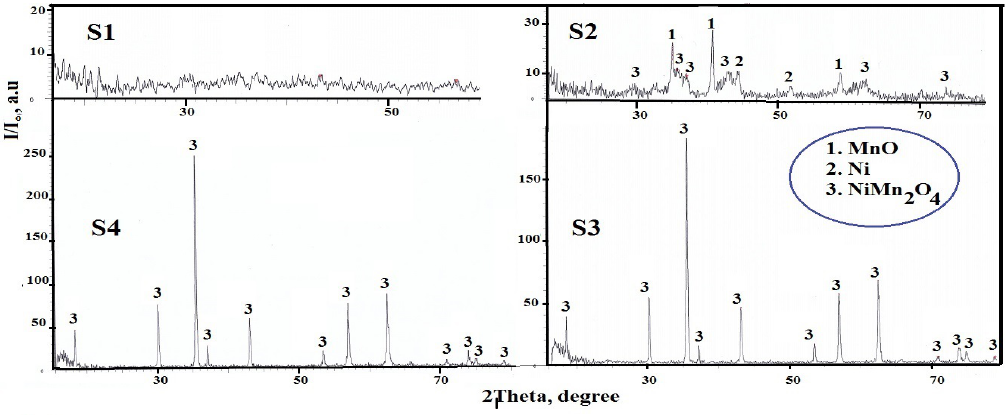
Figure 2. XRD patterns of S1, S2, S3 and S4 samples.